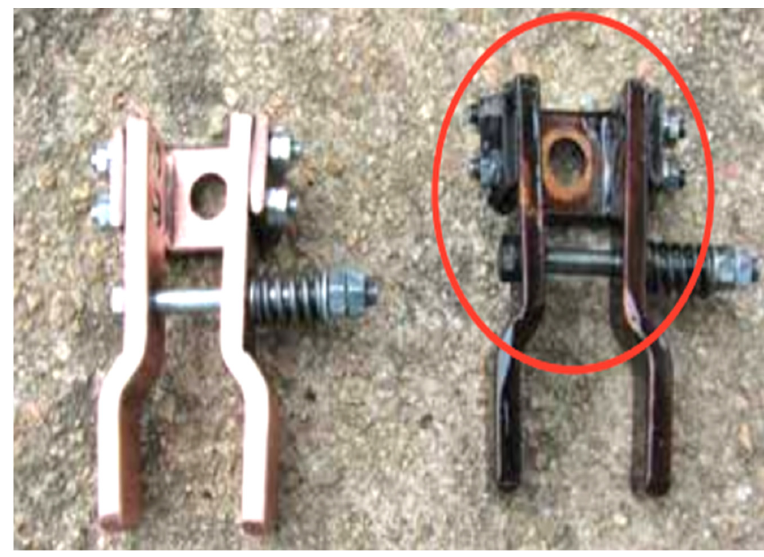
Figure 3. Severe burning of the arm contacts and springs